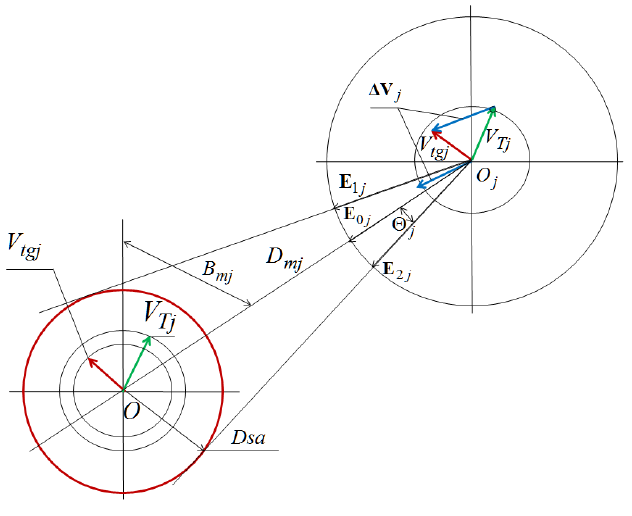
Fig. 6. Divergence